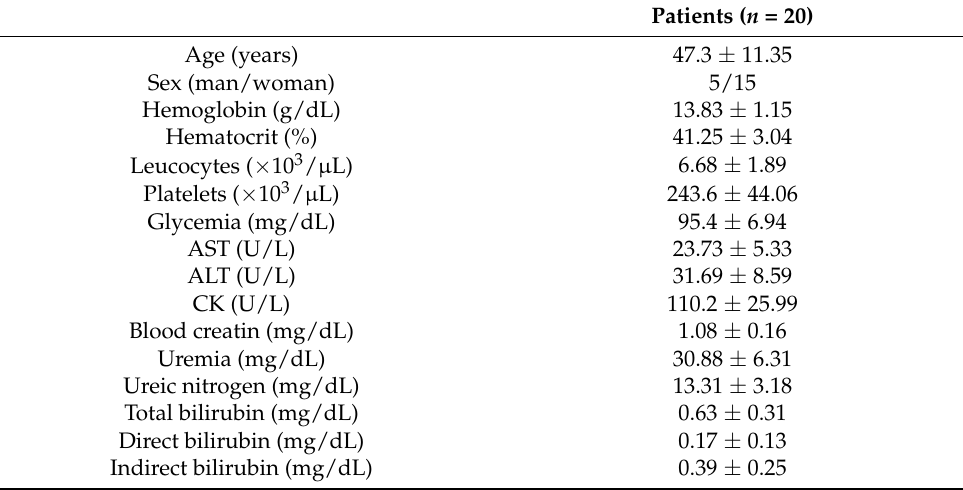
Table 1. Baseline characteristics of hypercholesteremic patients.